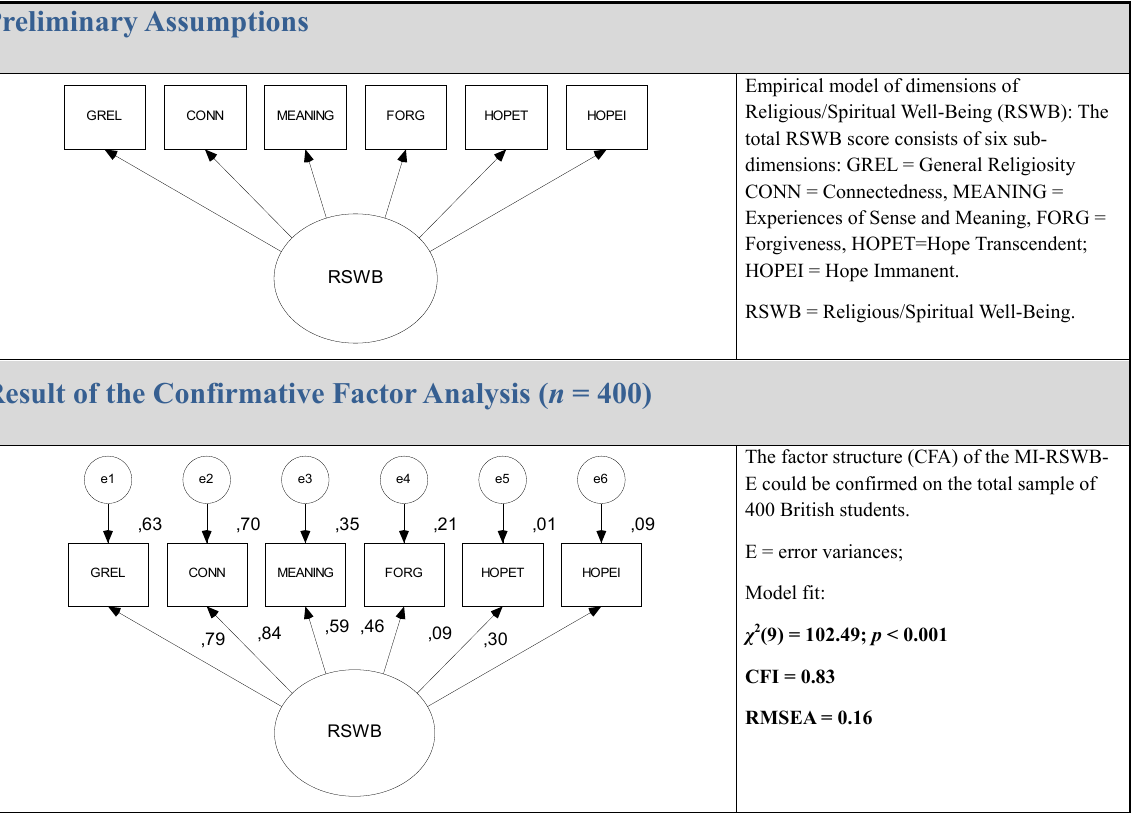
Figure 1. Factor loadings (standardized regression weights) together with several indices of model fit for MI-RSWB-E.